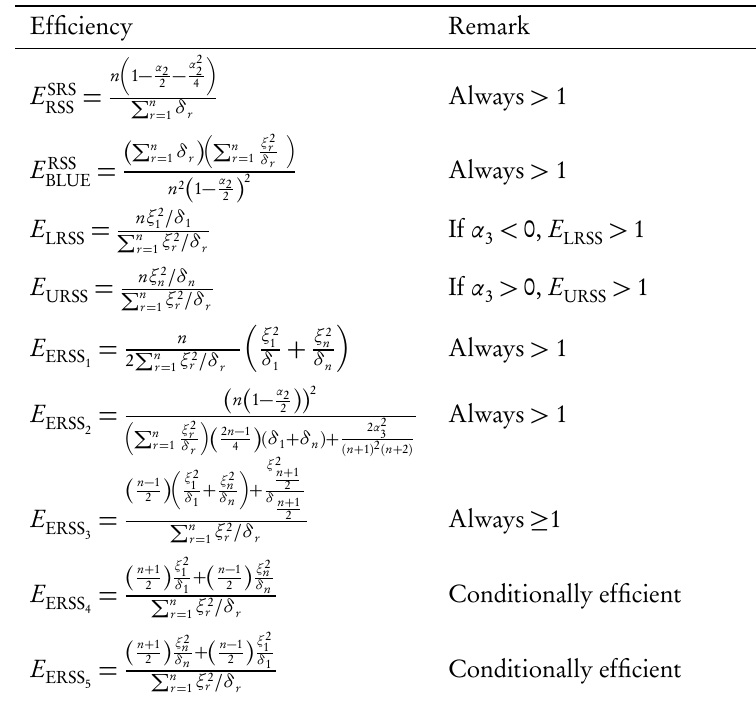
Efficiency comparison of estimators under RSS